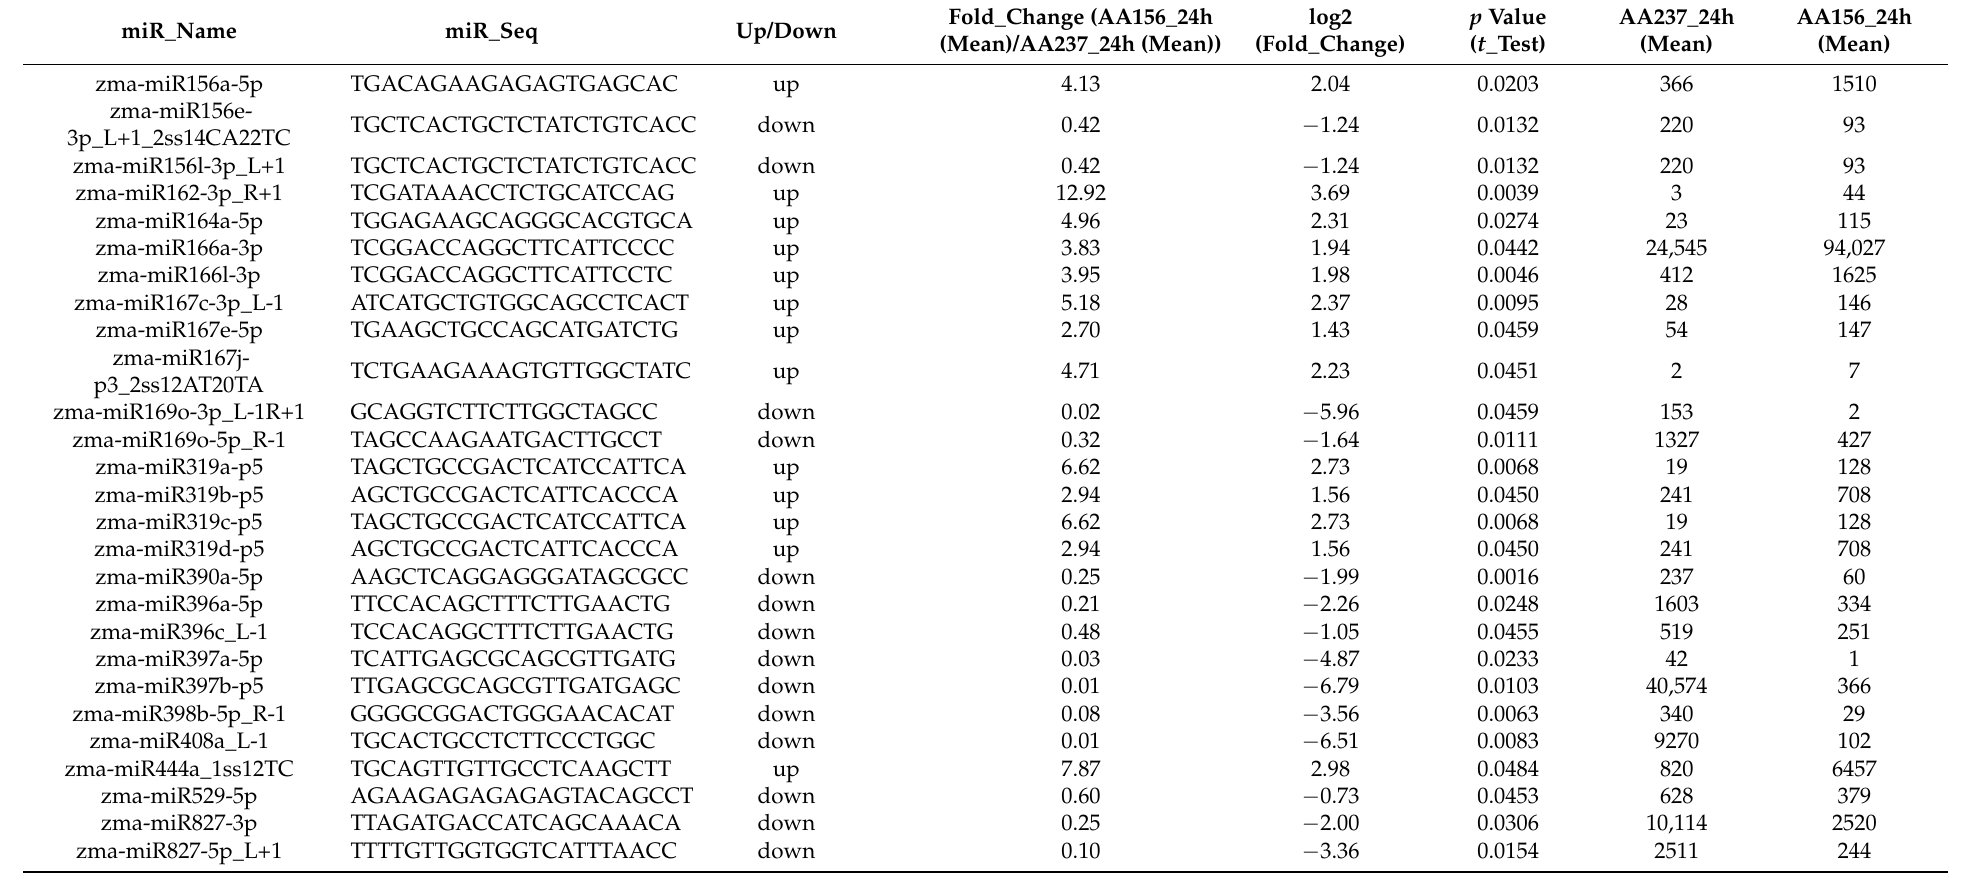
Table 1. A total of 27 known miRNAs were differentially